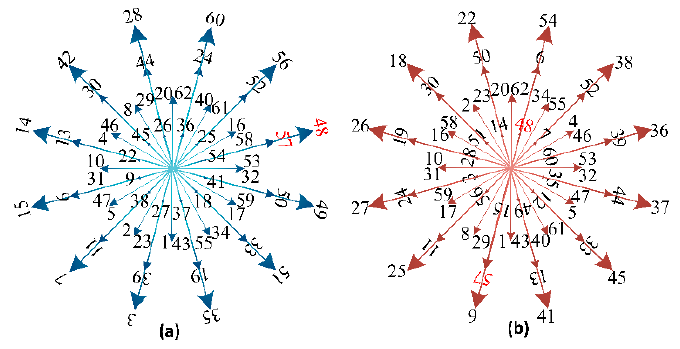
Figure 1. 6PIM model in ( a ) 𝛼 − 𝛽 , ( b ) 𝑧 (cid:2869) − 𝑧 (cid:2870)